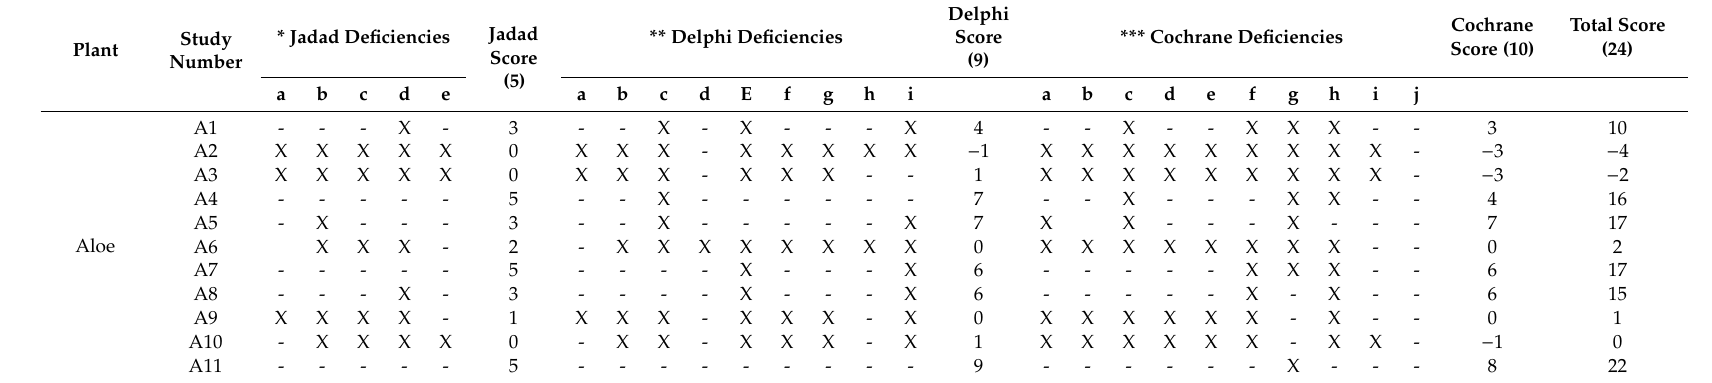
Table 4. Evaluation of clinical trials on the basis of various scales, where (X) represents the